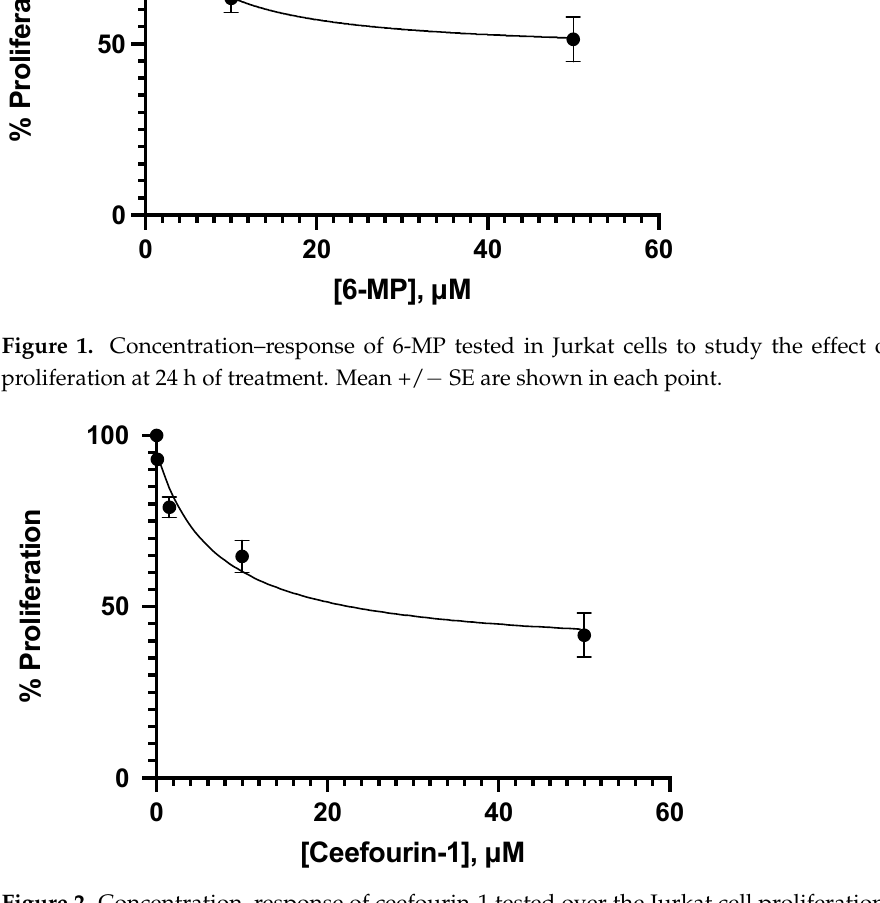
Figure 2. Concentration–response of ceefourin-1 tested over the Jurkat cell proliferation at 24 h of treatment. Mean +/ − SE are shown in each point.